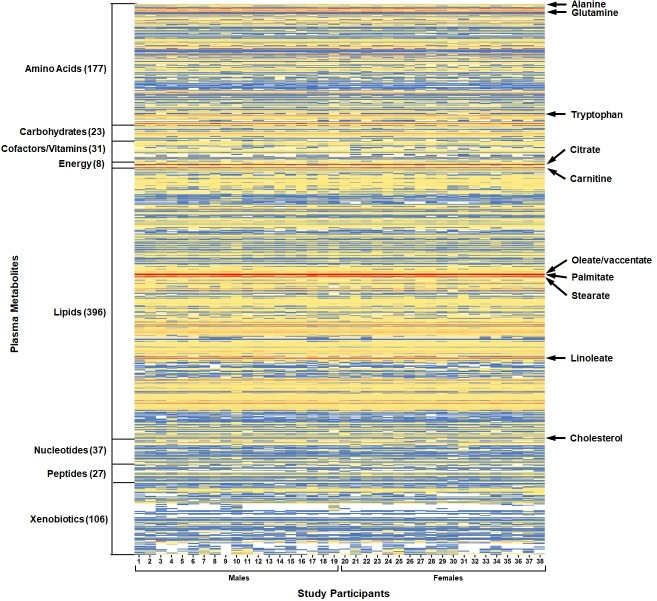
Plasma metabolite profiling of children with aberrant cholesterol.Metabolites identified in plasma (805 total) were normalized across the dataset (median = 1). Metabolites are classified into 8 chemical classes, with the number of metabolites in each chemical class indicated in brackets. Blank (white) cells indicate that metabolite was not detected in the plasma sample.